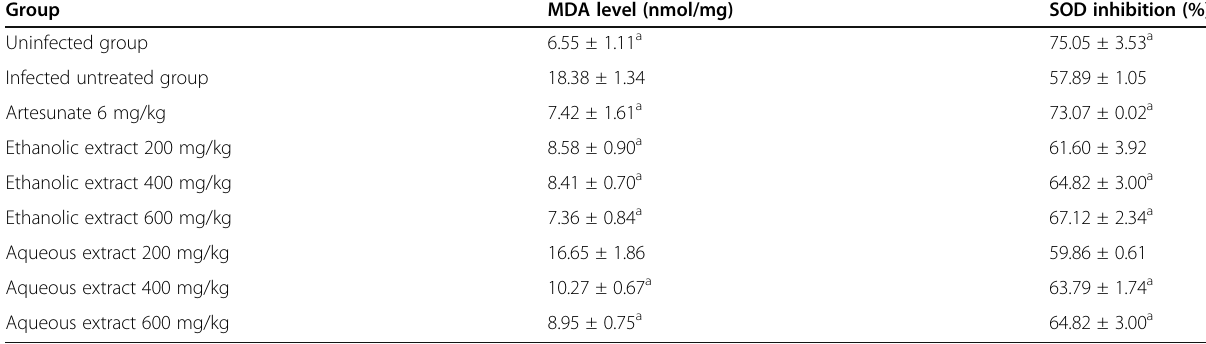
Table 3 In vivo antioxidant properties of the aqueous and ethanolic extracts during P. berghei ANKA infection